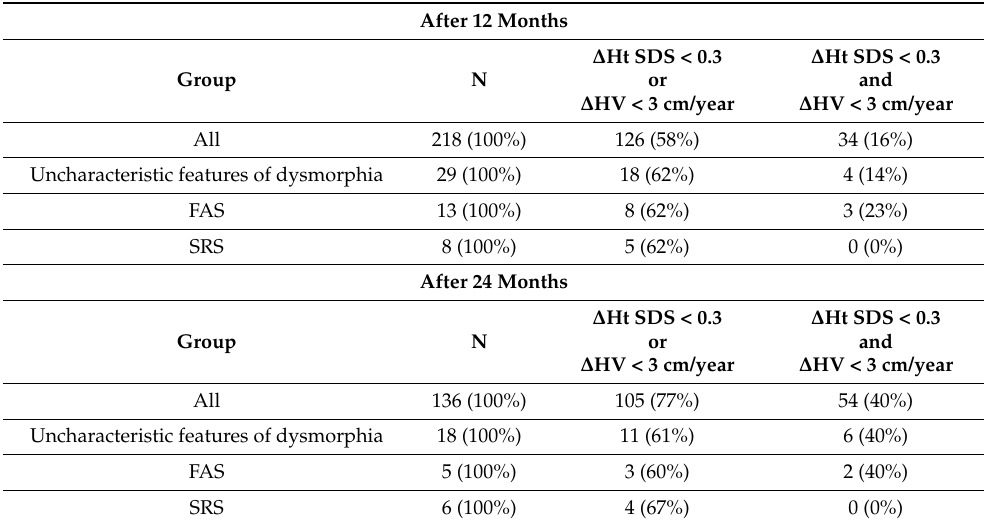
Table 5. Comparison of different growth response criteria to rhGH treatment.